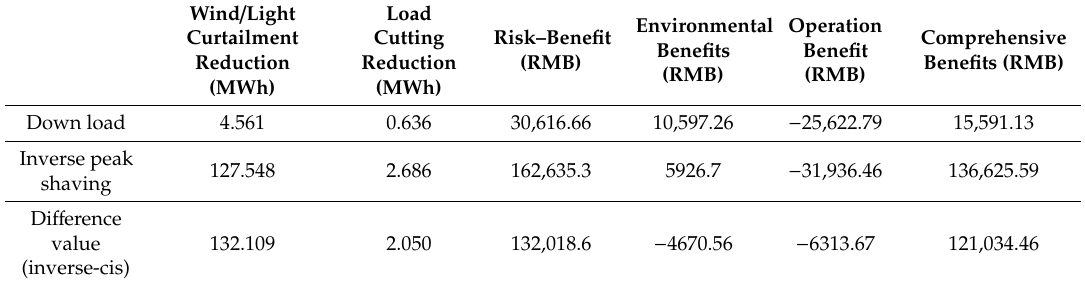
Table 7. Comparison of the robust benefits of clockwise and inverse peak